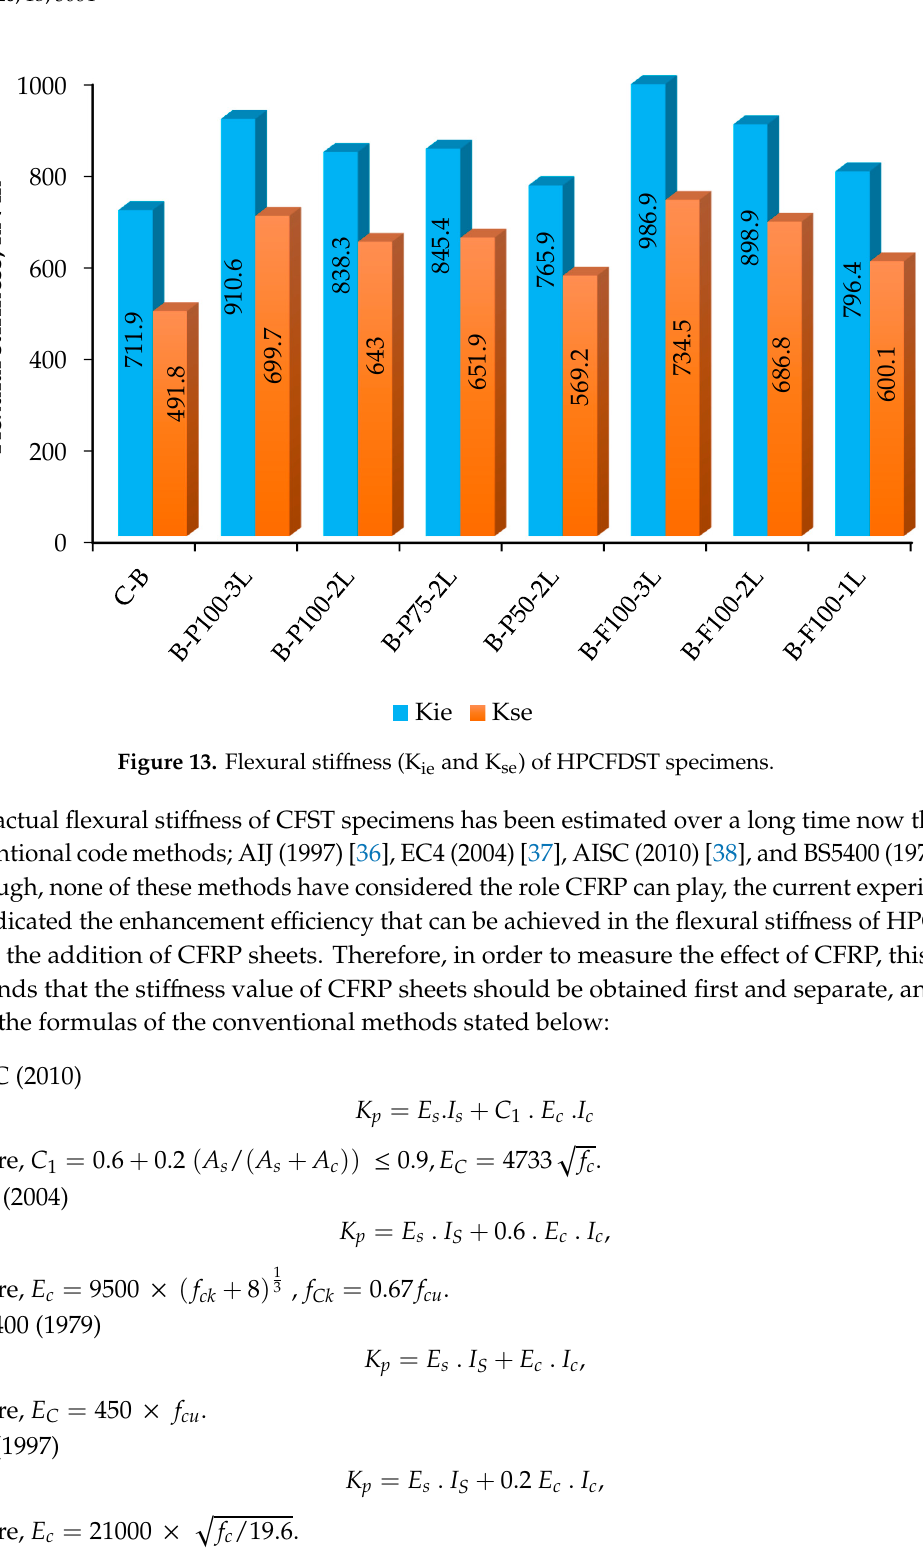
Figure 12. Typical relationships of bending moment–curvature: ( a ) reference specimen (B-C) and ( b ) integrated specimen (B-P100-2L).